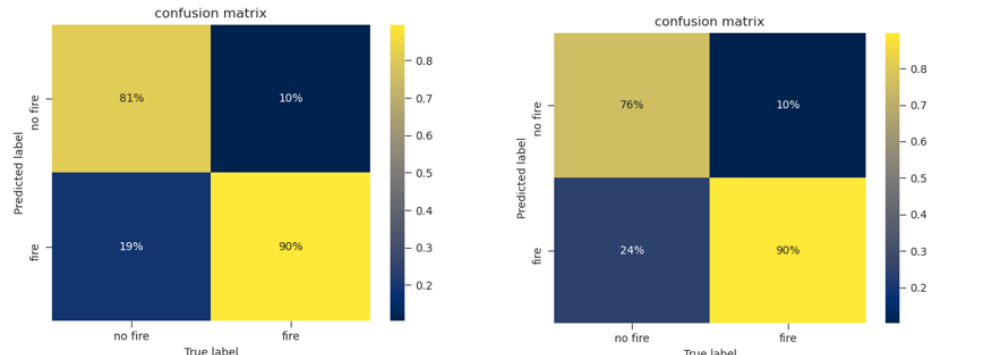
Figure 14. On the left, the confusion matrix for the summer analysis. On the right, the confusion matrix related to the winter season.